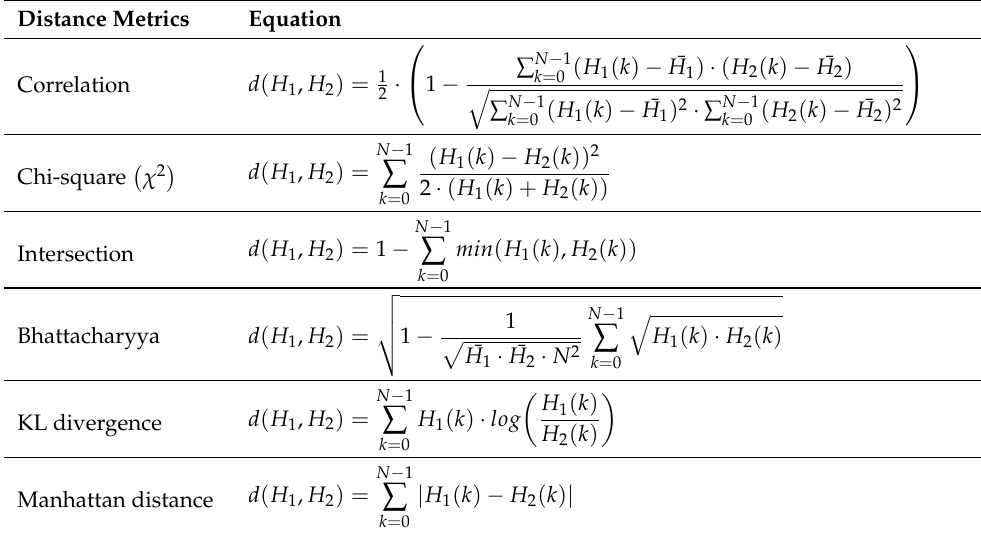
Table 2. Distance measures to compare 2 different histograms H 1 and H 2 of the same length. Usually, H 1 and H 2 are both